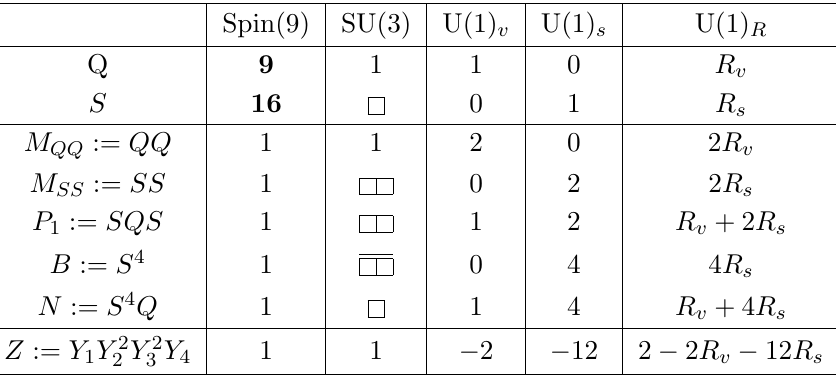
Table 9 . 3d N = 2 Spin(9) theory with ( N v ; N s ) = (1 ;